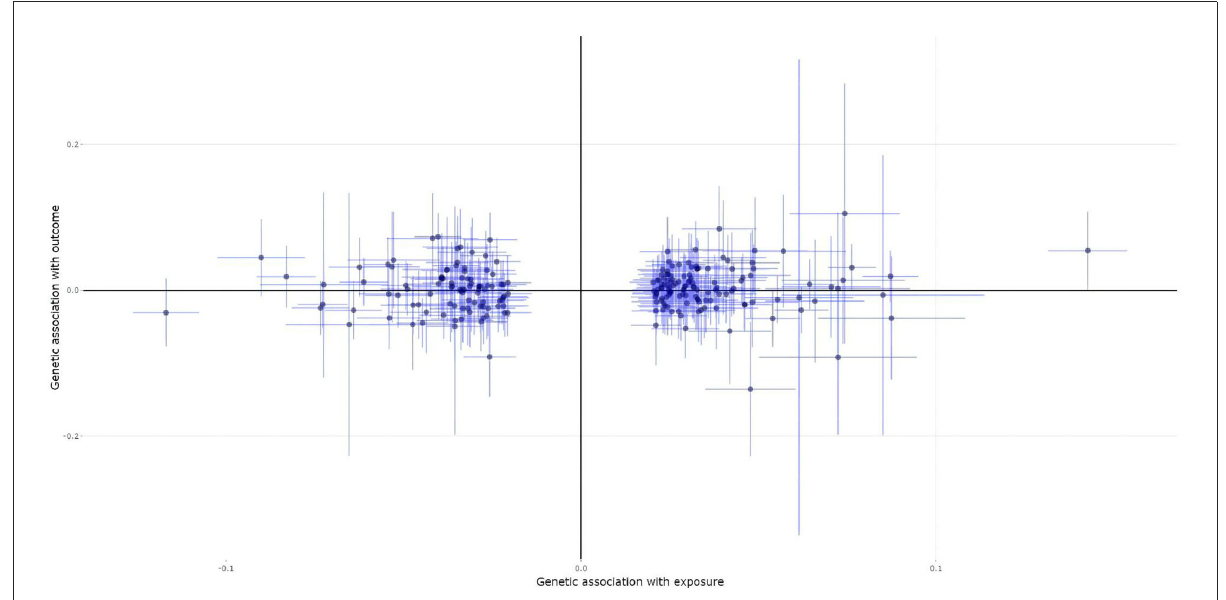
FIGURE1 The scatter plot for the Mendelian randomization (MR) analysis showing the causal estimates of bone mineral density (BMD) on the risk of multiple sclerosis (MS) using the contamination mixture method.